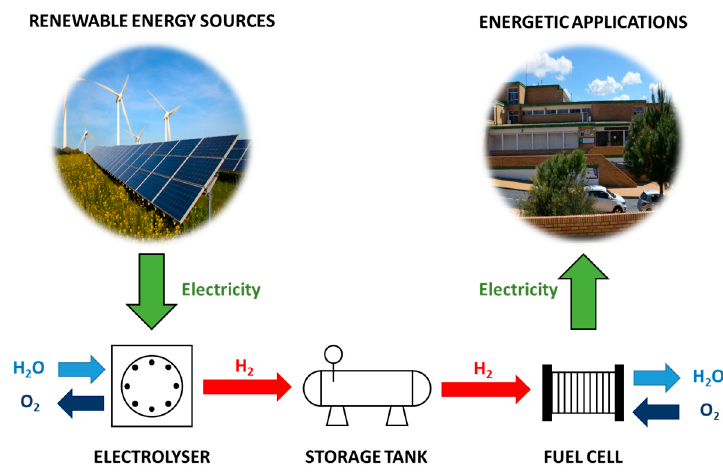
Figure 1. Use of hydrogen as energy vector.